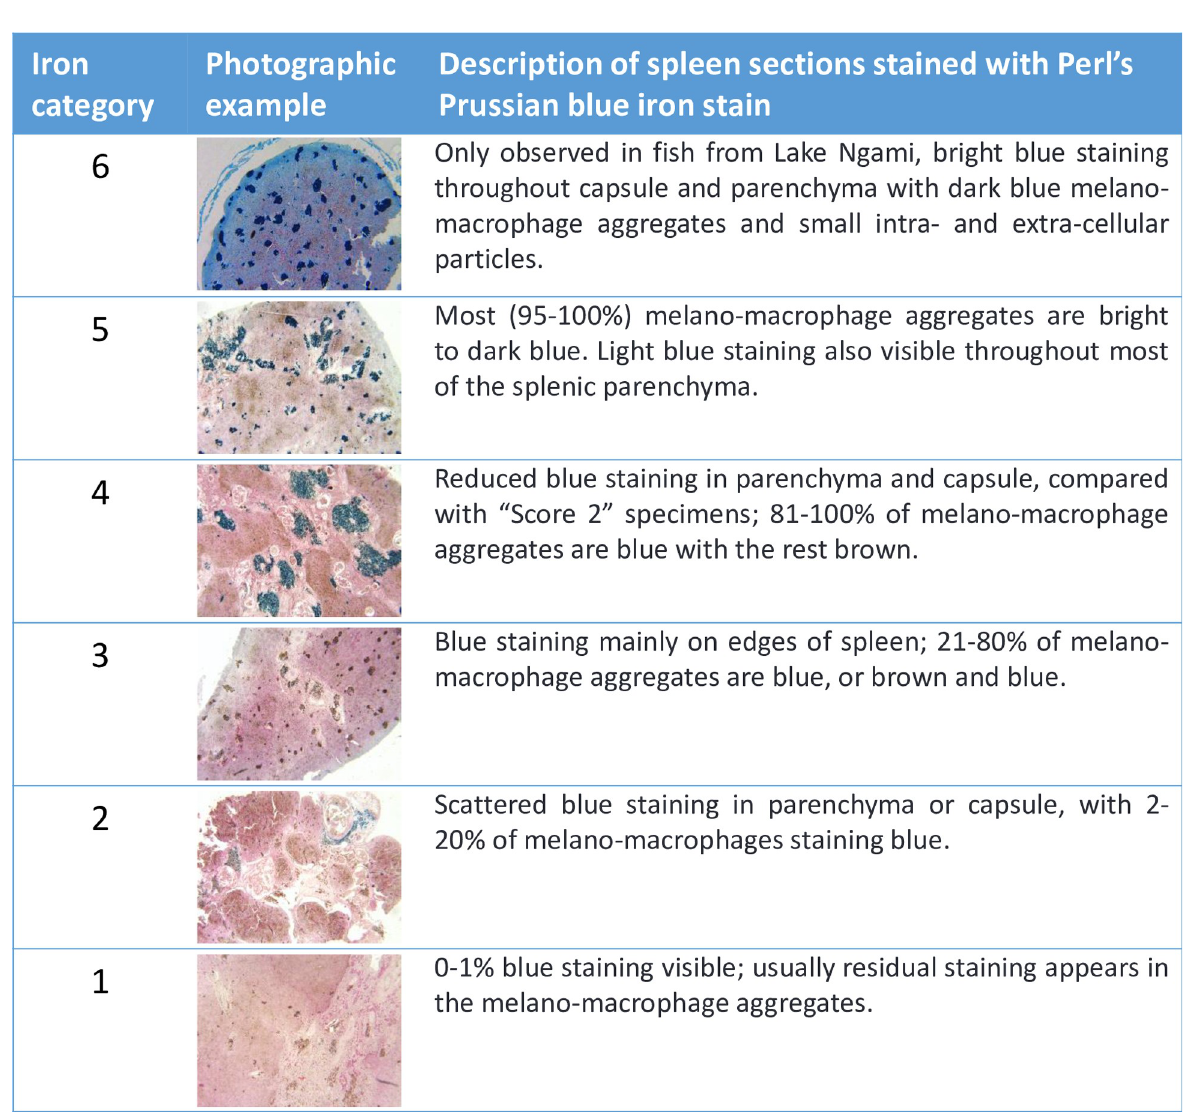
Fig 3. Iron category definitions for spleen sections stained with Perl’s Prussian blue iron stain. Categories 1–6 reflect the degree of iron staining in spleen sections, with 6 representing the most iron. Category 6 was only observed in Lake Ngami fish. Higher resolution images are available in S2 Fig.